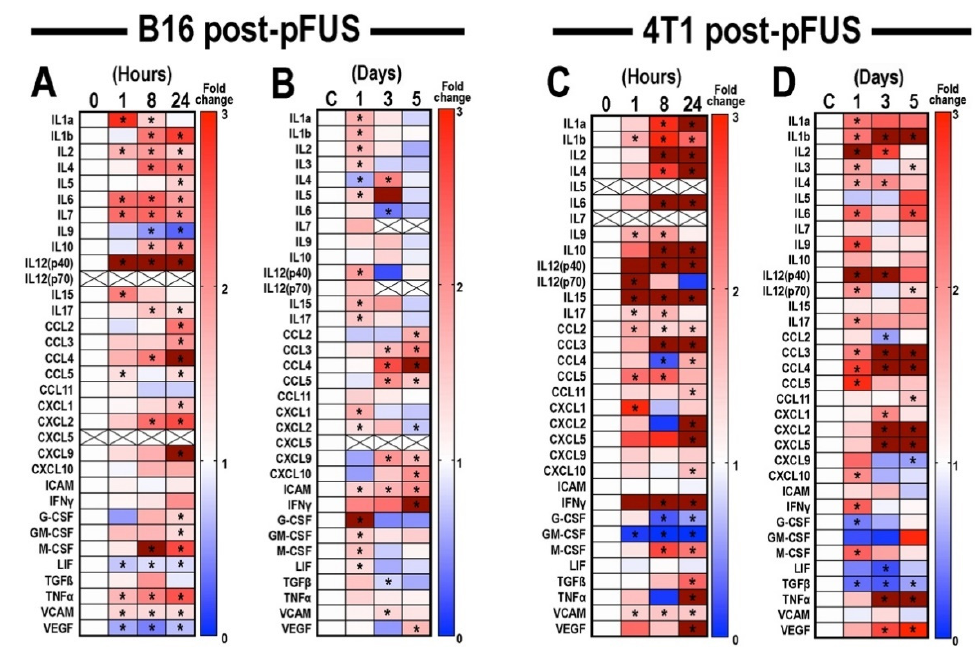
Figure 2. Time-course analysis of proteomic changes in TIME of mouse B16 melanoma and 4T1 breast tumor models ( n = 6 mice/tumor type/time point) following pFUS. Heat maps depicting fold changes in CCTFs over time of mouse ( A ) B16 melanoma or ( C ) 4T1 breast tumor models 1, 8, or 24 h post-pFUS treatment. For each protein, time points were normalized to values detected on un-sonicated tumors at day 0. See also Figures S1 and S3 for raw data. Temporal proteomic profile of ( B ) B16 and ( D ) 4T1 flank tumor models harvested at 1, 3, or 5 days post-pFUS. Data presented as fold changes between the mean value detected from the pFUS-treated group to their time-matched untreated controls. Increased fold changes are indicated in red, while decreased fold changes are shown in blue. Fold change >3.1 is displayed as dark red. Time points with p -values < 0.05 were considered statistically significant (ANOVA) and marked by asterisks IL: Interleukin; CCL: Chemokine